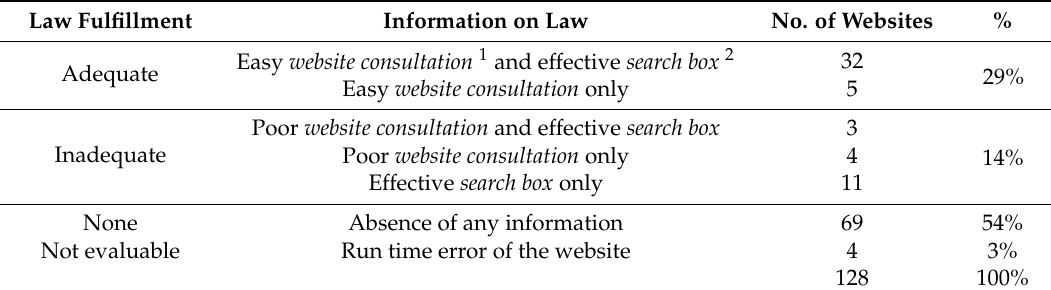
Table 1. Results of our investigation about the information on the Law 413/1993 on Faculties’ websites. Law